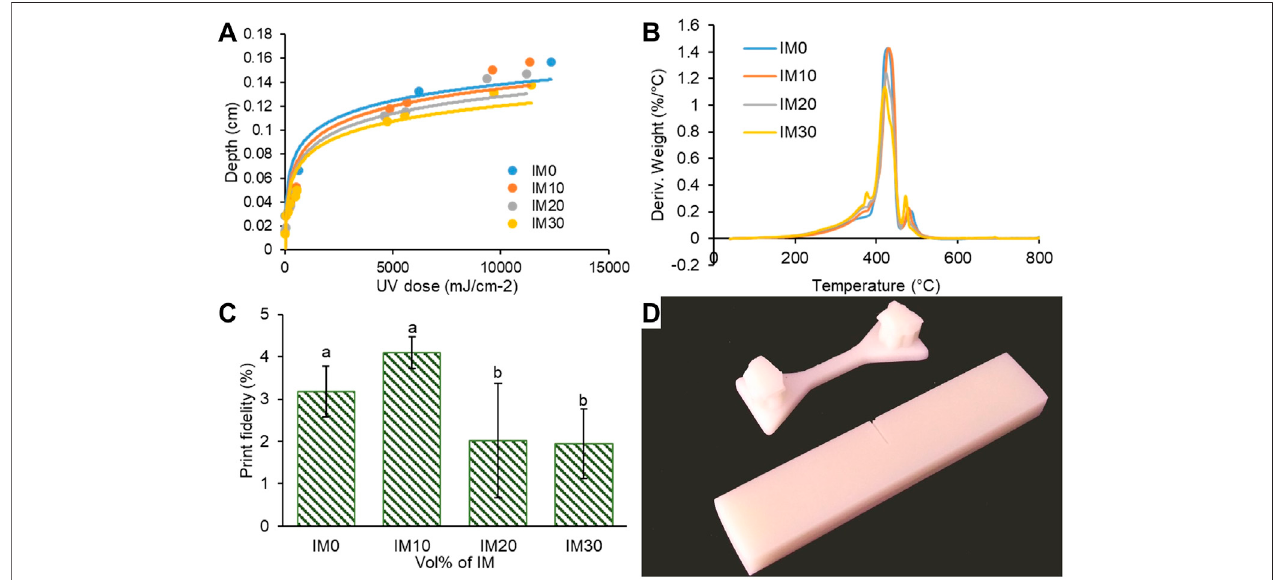
FIGURE 2 | (A) Cure depth vs UV energy dosage for mAESO/IM/PEGDA/nHA nanocomposite inks. (B) Representative derivative weight loss thermograms of curednanocomposites. (C) Print fi delityofthenanocompositescalculatedbymeasuringthepercenterrorof3Dprintedobjects.Dataarepresentedasmean±SD( n =7 ofeachcomposition).One-wayANOVAandTukey ’ smultiplecomparisontestwereusedforstatisticalanalysis.Differentsmall-caselettersindicatestatisticalsigni fi cance